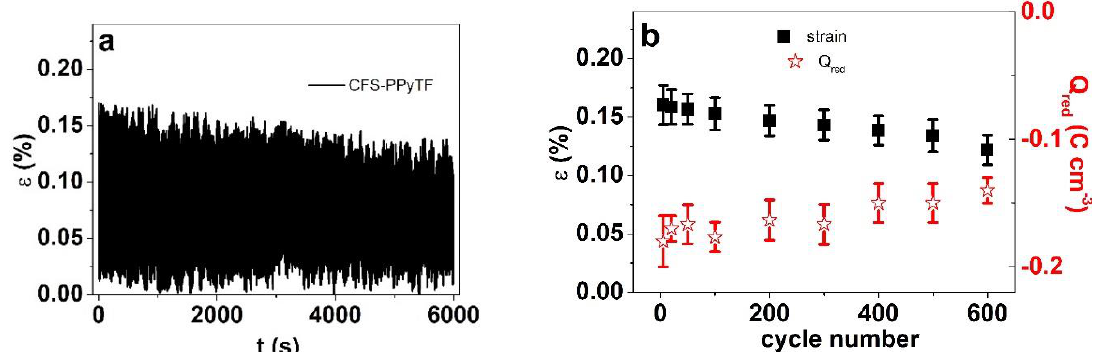
Figure 6. Square wave potential steps at 0.1 Hz (600 cycles) in potential range 0.65 V to − 0.60 V in CMC solution of CFS-PPyTF samples showing in ( a ) the strain ε against time and ( b ) the strain ε and charge density at reduction Q red against cycle number.